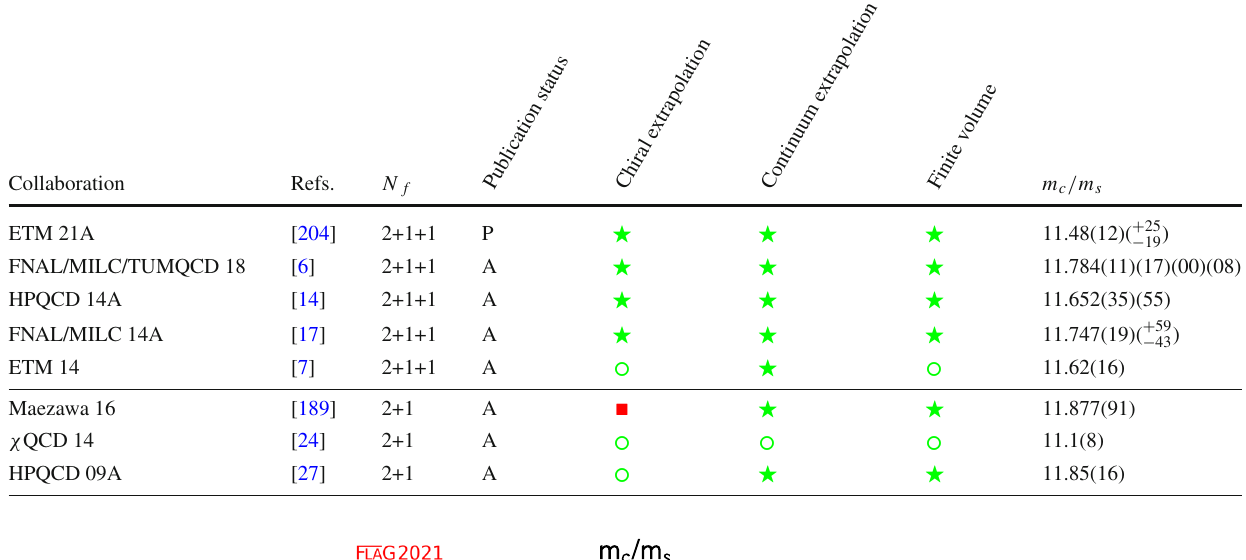
Table 13 Lattice results for the quark-mass ratio m c / m s , together with the colour coding of the calculations used to obtain them